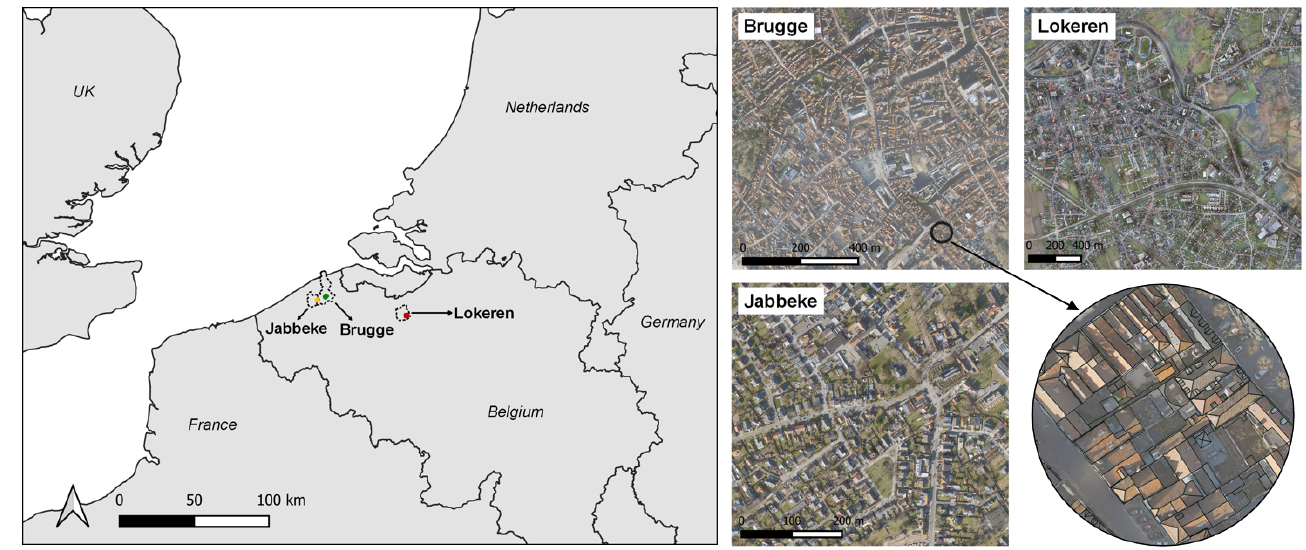
Figure 1. Geographic location and visual overview of the training (Brugge), validation (Jabbeke), and test (Lokeren) sets. Colored dots delineate the considered regions within the municipality borders (dotted lines). The magnification at the bottom right shows an example of the complexity of the rooftop structure and its overlying polygon